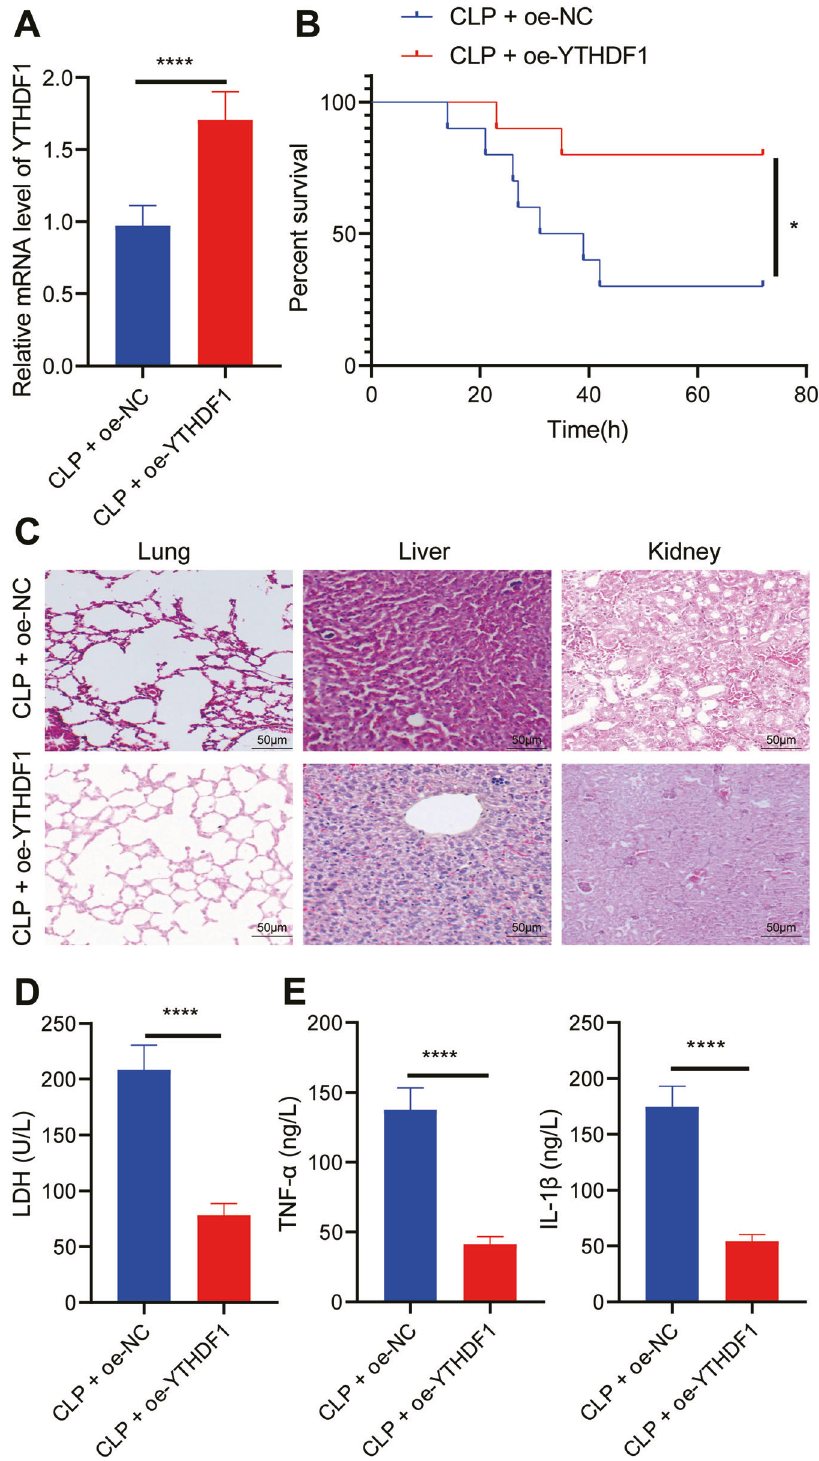
Fig. 5 Overexpression of YTHDF1 inhibits in fl ammation in CLP-induced septic mice. A RT-qPCR to detect the expression of YTHDF1 in PBMCs of mice with different treatment. B The survival rates of mice with different treatment. C The pathological changes of lung, liver and kidney tissues of mice with different treatment observed by HE staining. D LDH levels in serum of mice with different treatment. E The expression of TNF- α and IL-1 β detected by ELISA. There were 10 mice in each group. * p < 0.05; ** p < 0.01; *** p < 0.001; **** p < 0.0001. Separation of PBMCs identify the differentially expressed genes (DEGs) in sepsis with |log fold This study selected 40 patients with sepsis hospitalized in Cancer Hospital change (FC) | > 1 and p value < 0.05 as the threshold. UbiBrowser database of Shantou University Medical College from June 2018 to June 2020, and 40 was applied to predict E3 ubiquitin ligase of the protein, and m6A2Target healthy individuals who underwent physical examination in the hospital at database to predict mRNA m6A modi fi er.